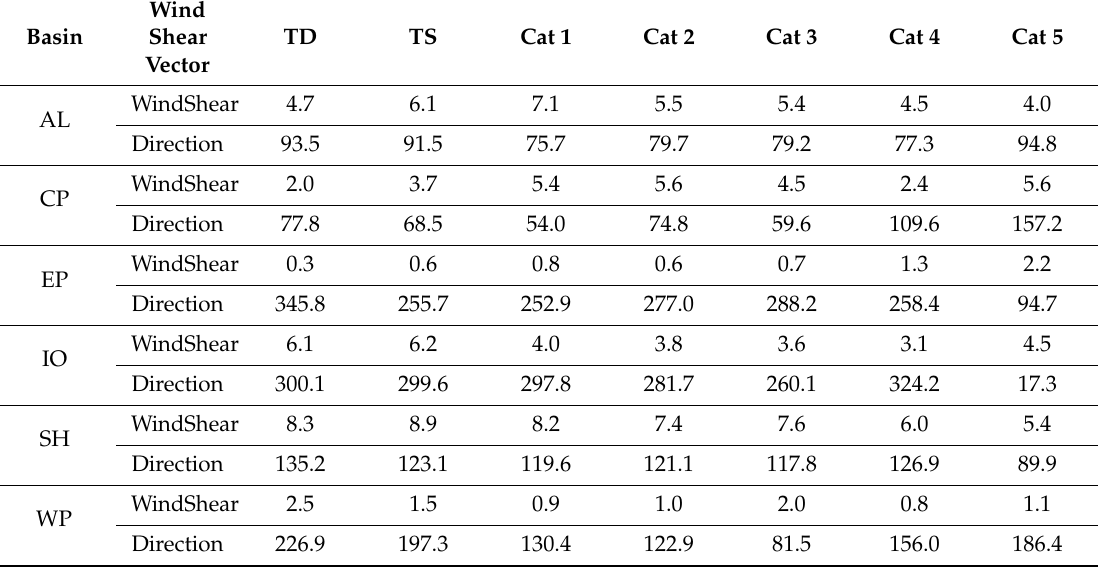
Table 5. Averaged 200–850 hPa wind shear vector at each intensity category over each TC basin (Direction: clockwise from the North in degree; Wind shear unit: m s − 1